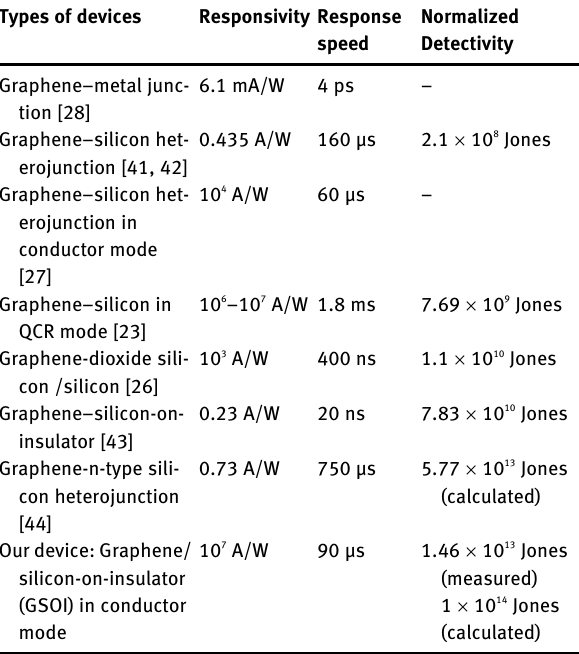
Table  : Summary of device parameters of several typical graphene photodetectors previously reported, and our device, including responsivity, response speed, and normalized